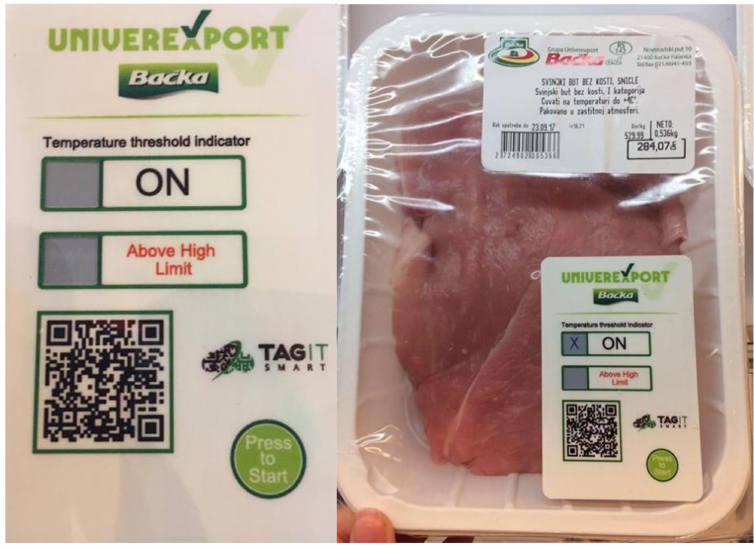
Figure 14. SmartTag with irreversible thermochromic sensor used in evaluation.